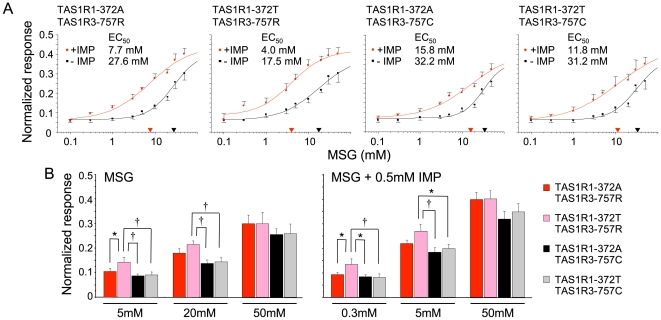
Concentration-response relationships of the calcium concentrations in HEK293 cells transfected with human TAS1R1 and TAS1R3 variants after stimulation with increasing MSG, and MSG+0.5 mM IMP.(A) Dose-response curves of MSG, and MSG+0.5 mM IMP concentration series in cells expressing the TAS1R1/TAS1R3 variants [TAS1R1-372A, -372T, TAS1R3-757R and -757C]. Black and red lines indicate the responses to MSG and MSG+0.5 mM IMP, respectively. Responses have been normalized to those of isoproterenol (ISO, 10 µM), which activate the endogenous βadrenergic receptor [12]. Each point represented the mean (±S.E.) from 10∼18 independent experiments. Half maximal responses (EC50) for TAS1R1/TAS1R3 variants were calculated from the dose-response curves. The X-axis triangles present the EC50 values for MSG (black) and MSG+0.5 mM IMP (red). (B) The responses of TAS1R1/TAS1R3 variants at concentrations of MSG (5, 20, 50 mM) and MSG (0.3, 5, 50 mM)+0.5 mM IMP. The values are means (±S.E.) from 14∼18 independent experiments. Asterisks indicate statistically significant differences (*: p<0.05, †: p<0.01, Fisher's PLSD as a Post-hoc test).